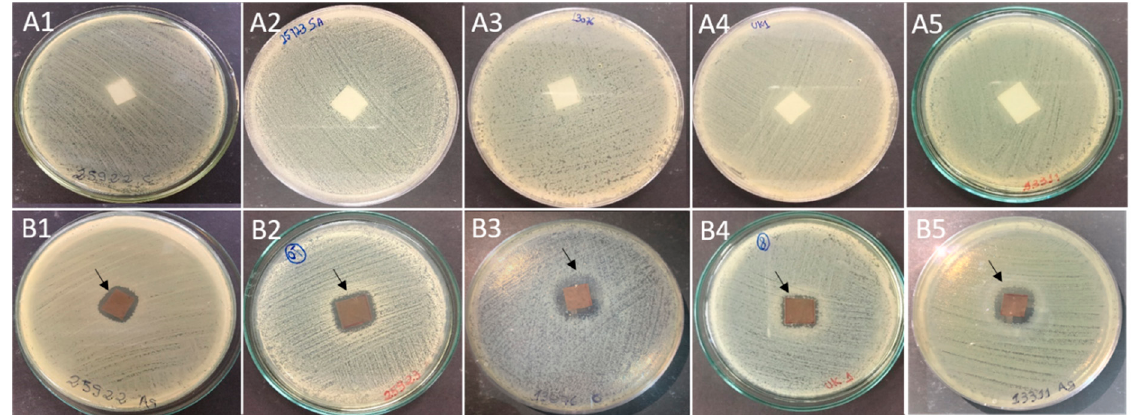
Figure 4. Antibacterial activity of films incorporated with bio-AgNPs indicated by agar diffusion assay. The bacteria growth was inhibited in the contact area with bio-AgNPs films, where an inhibition halo was observed (arrowheads). ( A ) Control (without bio-AgNPs) and ( B ) Treatment (with bio-AgNPs); 1: E. coli ATCC 25922; 2: S. aureus ATCC 25923; 3: Salmonella Enteritidis ATCC 13076; 4: Salmonella Typhimurium UK-1 ATCC 68169; 5: Salmonella Typhimurium ATCC 13311.